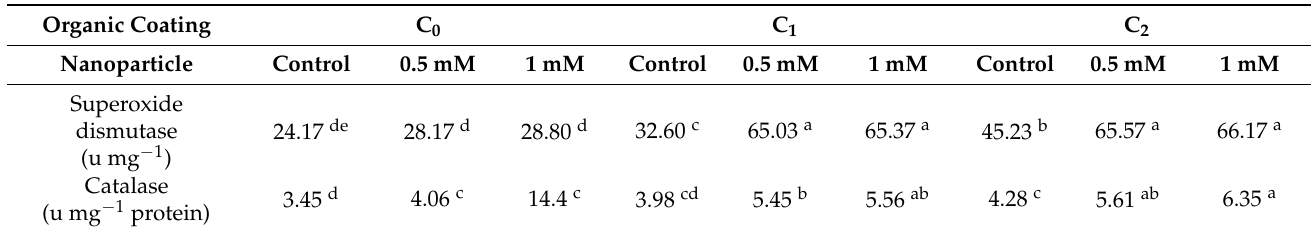
Table 12. Effect of organic coating and nanoparticle on superoxide dismutase and catalase. Organic Coating C 0 C 1 C 2 Nanoparticle Control Superoxide